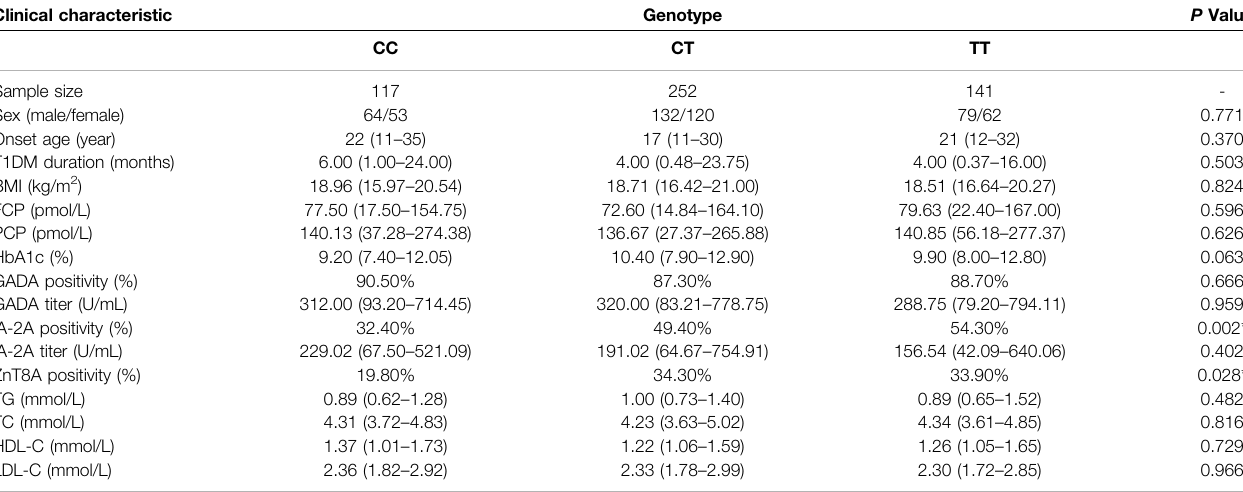
TABLE 6 | Clinical characteristics of participants with T1DM with different genotypes of rs1143643. Clinical characteristic